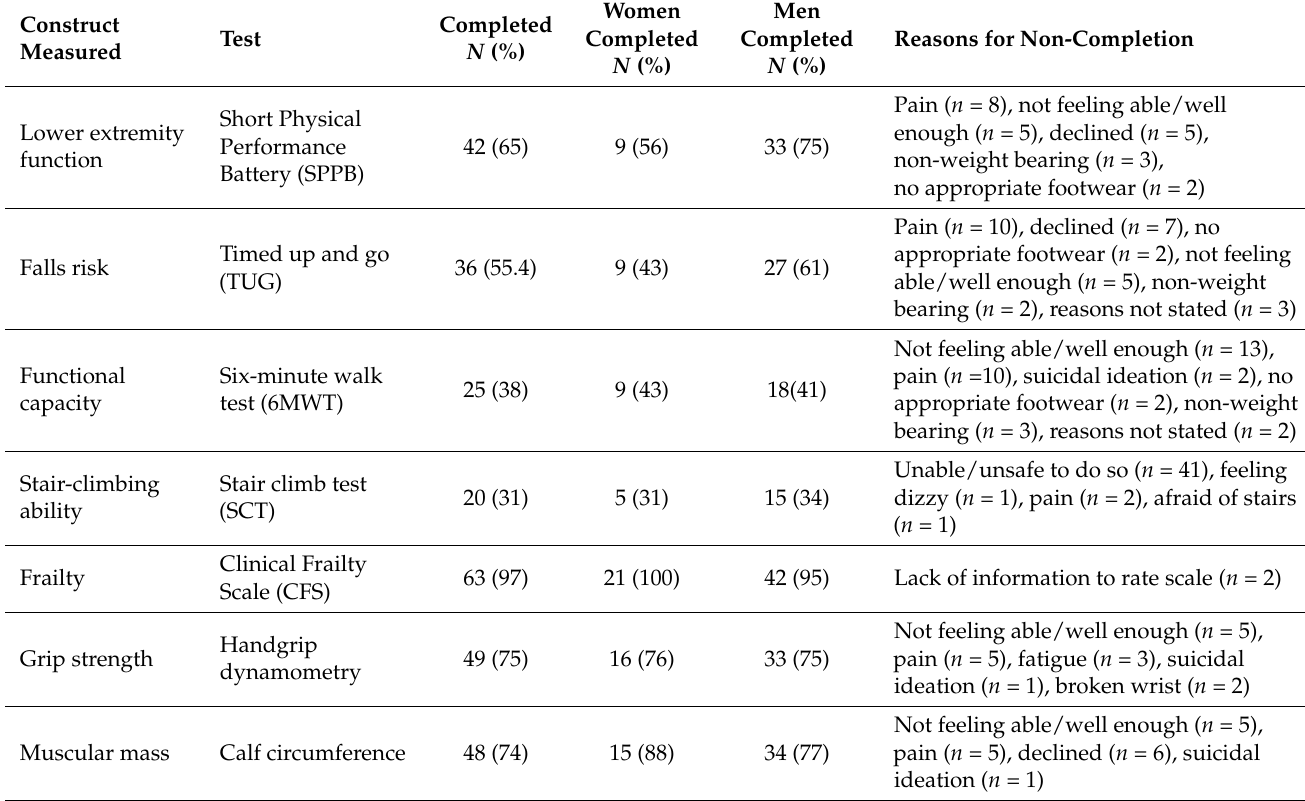
Table 3. Numbers of participants who completed physical test